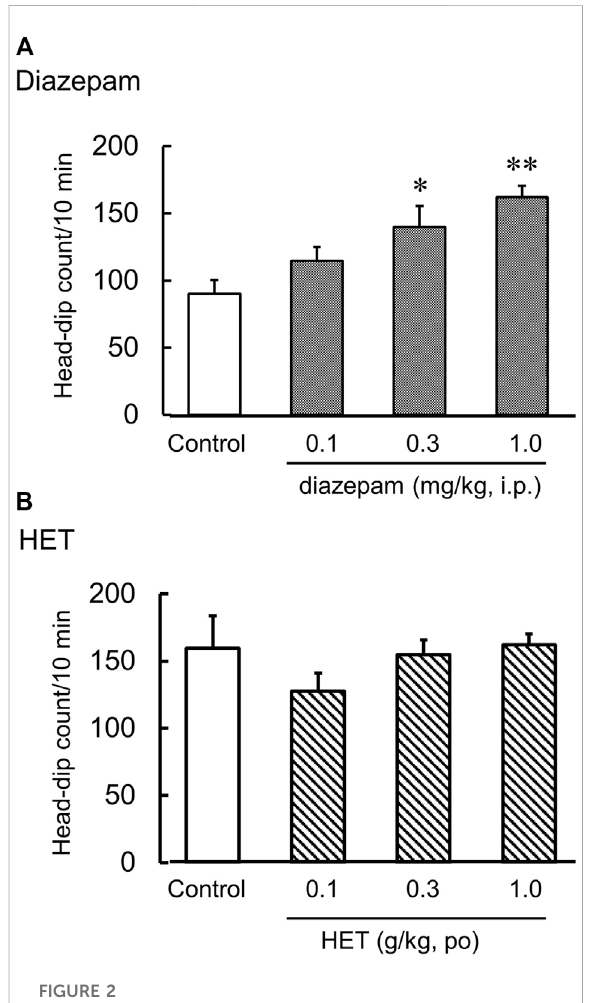
FIGURE 2 Results of the hole-board test. Effect of diazepam (A) and hochuekkito(HET) (B) on thenumber ofhead dips incontrol mice, mice single administered diazepam and mice administered HET for 2 weeks. Data are shown as mean ± standard error of mean(SEM); n =6 – 8pergroup.*: p < 0.05(vs.control),**: p < 0.01 (vs. control).